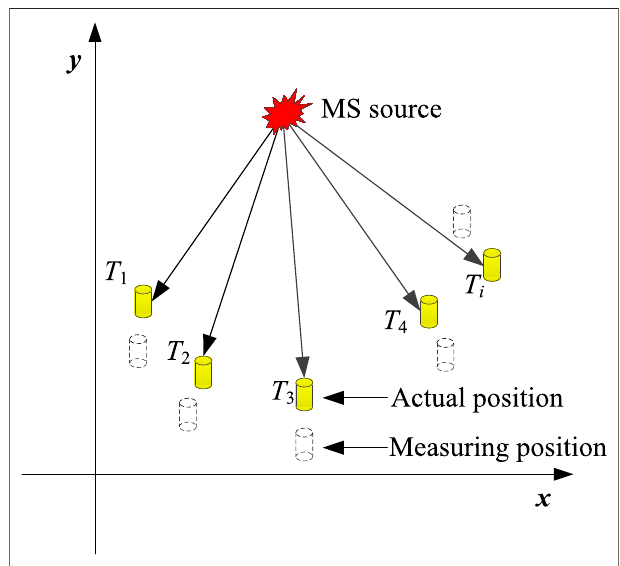
FIGURE 1 | Schematic diagram of the source location with sensor coordinate